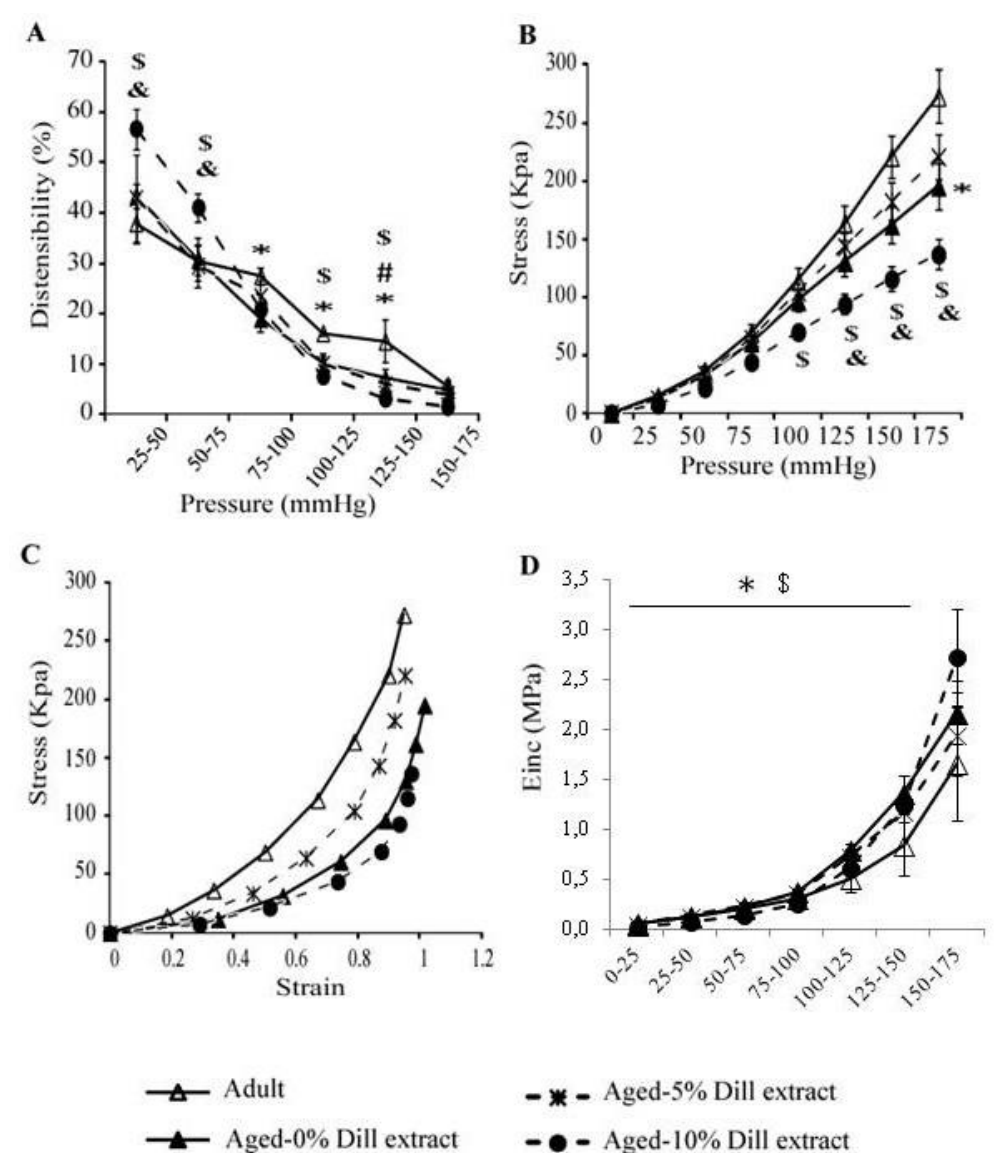
Figure 5. Mechanical parameters of the ascending aorta of untreated 5% DE- or 10% DE-treated aged mice, as well as untreated (control) adult animals. ( A ) Aortic distensibility-pressure increment relation; ( B ) circumferential stress-pressure relation; ( C ) stress-strain relation; ( D ) incremental elastic modulus (Einc)-pressure increment relation. * Significant di ff erence between untreated adult and untreated aged mice (two-way ANOVA followed by LSD test if necessary, p ≤ 0.05). & Significant di ff erence between 10% DE-treated aged mice and untreated adult mice (two-way ANOVA followed by LSD test if necessary, p ≤ 0.05). $ Significant di ff erence between 10% DE-treated aged mice and untreated aged mice (two-way ANOVA followed by LSD test if necessary, p ≤ 0.05). # Significant di ff erence between